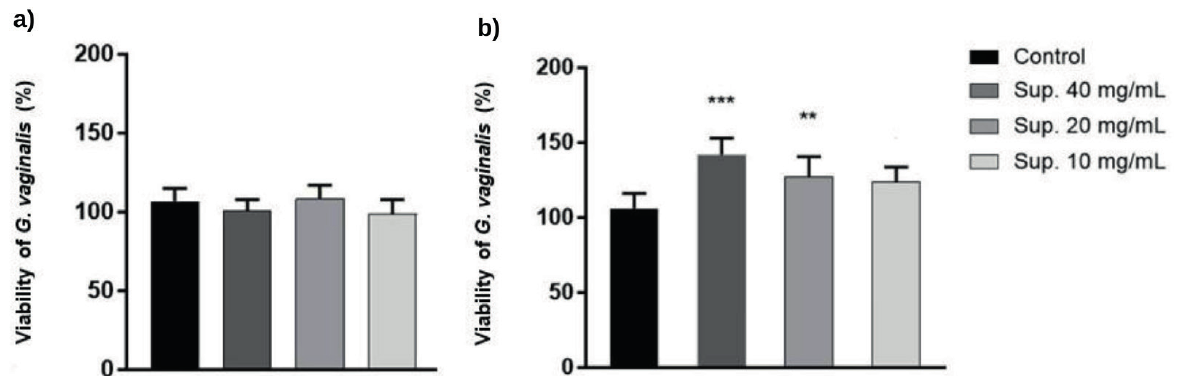
Figure 3. Effect of thermolabile substances on the antagonist action of the culture supernatant of Lactiplantibacillus plantarum 6.2 used at different concentrations against Gardnerella vaginalis after 24 h (a) and 48 h (b) of incubation. Each value corresponds to the mean ± standard deviation of triplicates. Signifi cant differences from the control are indicated by asterisks (***p < 0.0005, **p <